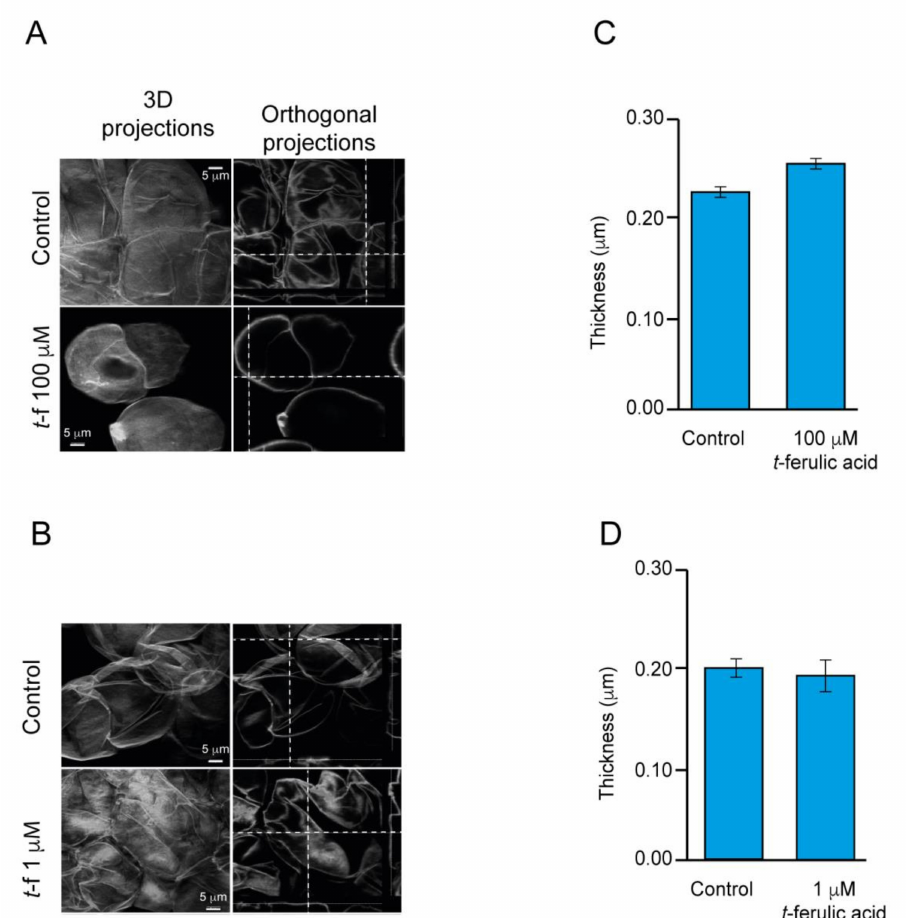
Figure 5. Determination of cell wall thickness during 12 h of treatment with ferulic acid in avocado Hass embryos. Three-dimensional projection base confocal microscopy analysis, intersections of dotted lines indicate the angle of analysis ( A , B ). The thicknesses of the cell wall were measured considering 30 orthogonal projections and the statistical analysis was made by R ( C , D